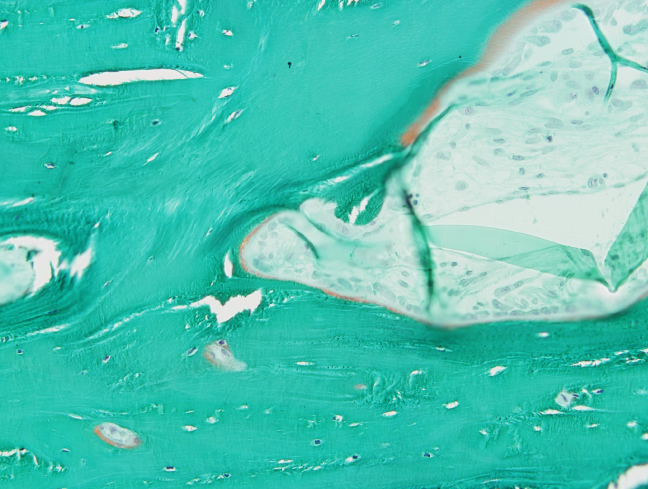
green. Osteoid: orange. Cat 2 of Group 1 specimen. (Masson-Goldner -